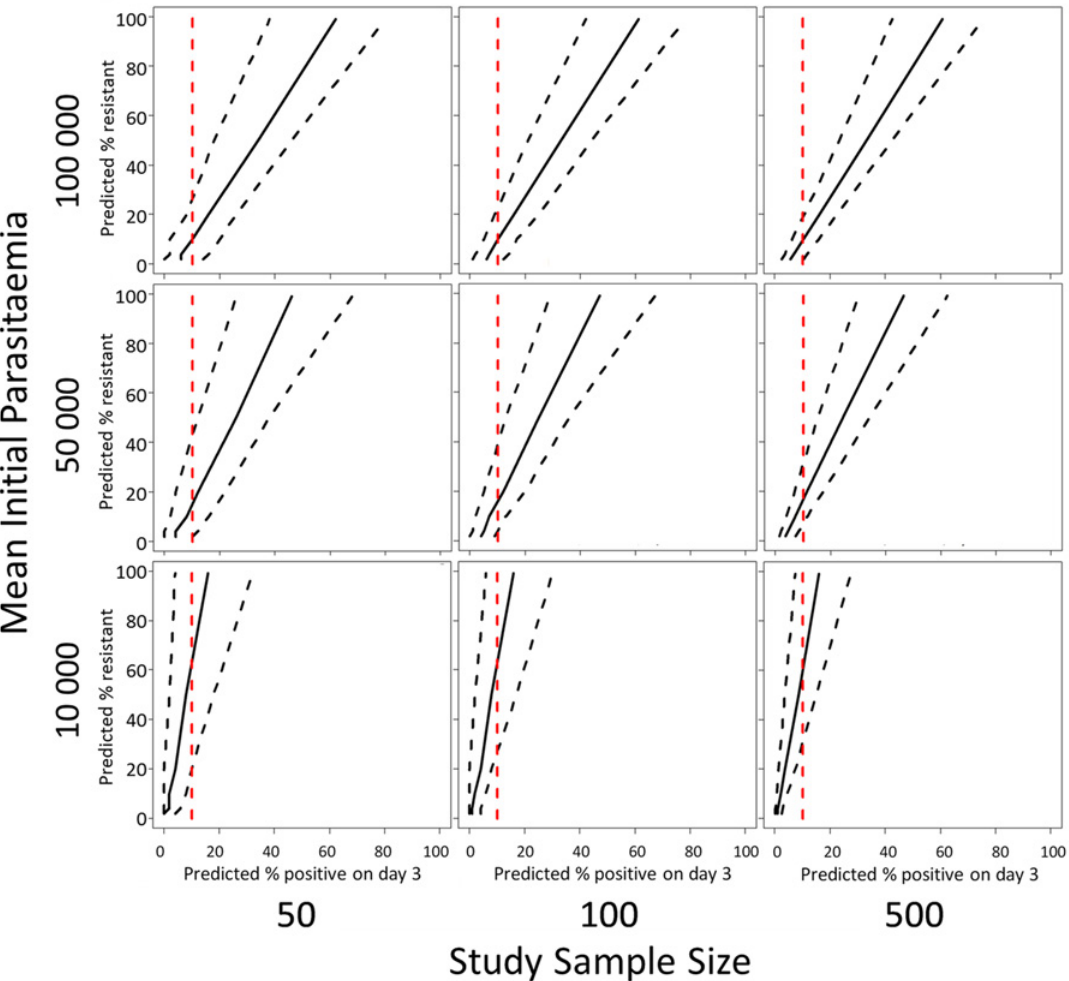
Fig 5. A plot of the simulation model prediction for the relationship between the percentage of patients parasitaemic after 3 days of treatment and the percentage of ‘ resistant ’ infections in the sample (solid black lines) with 95% prediction interval (dashed black lines). This prediction is plotted with a 10% threshold for the percentage of patients positive on day-3 of treatment (red dashed line). The rows of the panel represent three different assumptions about the geometric mean parasitaemia on admission and the columns of the panel represent three different assumptions about the study sample